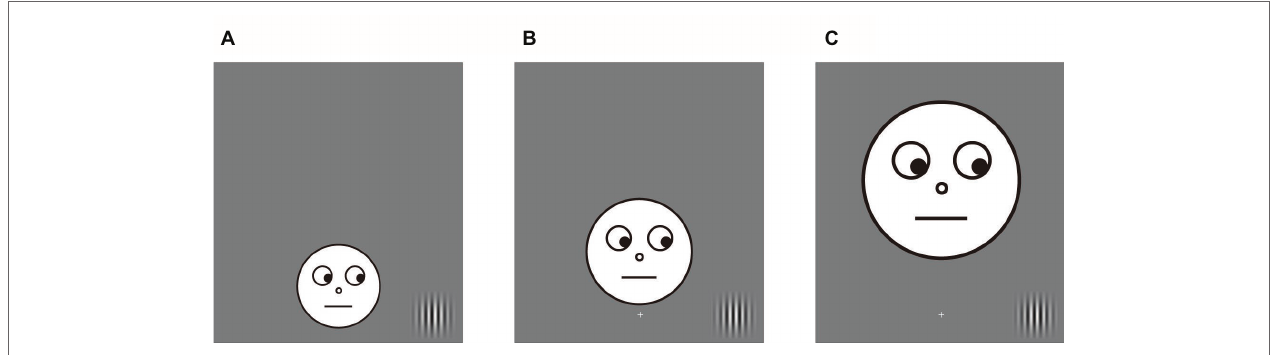
FIGURE 4 | Examples of facial stimuli in Experiment 3. Eyes of the facial image accurately looked at the possible target locations. (A) An example of the +2.5 ° condition. (B) An example of the +5.0 ° condition. (C) An example of the +7.5 °